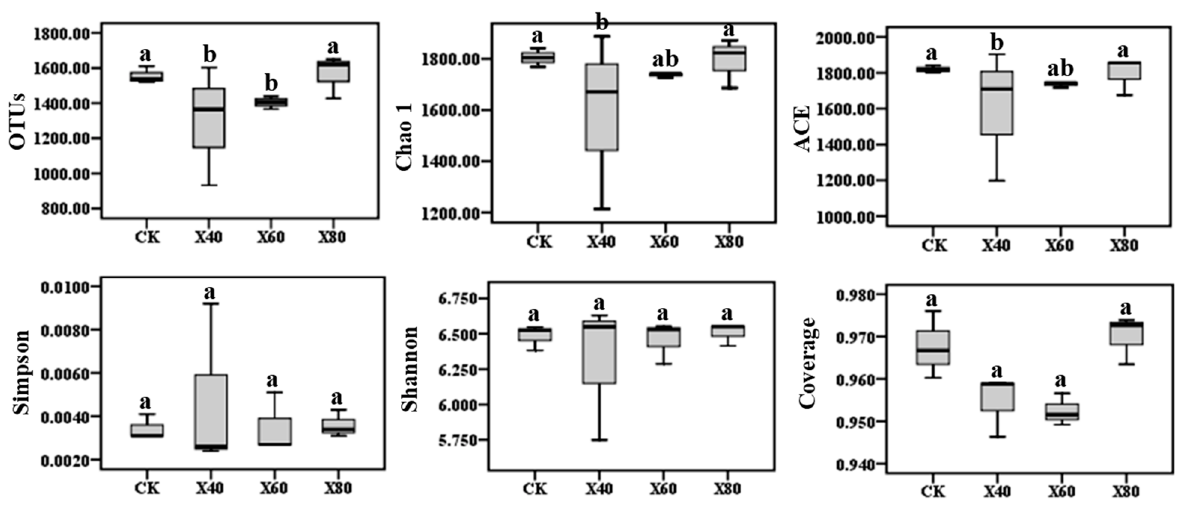
Figure 7. Soil microbial abundances of bacteria in CK, X40, X60, and X80 systems. Different letters indicate significant differences ( p < 0.05; Student’s t -test).